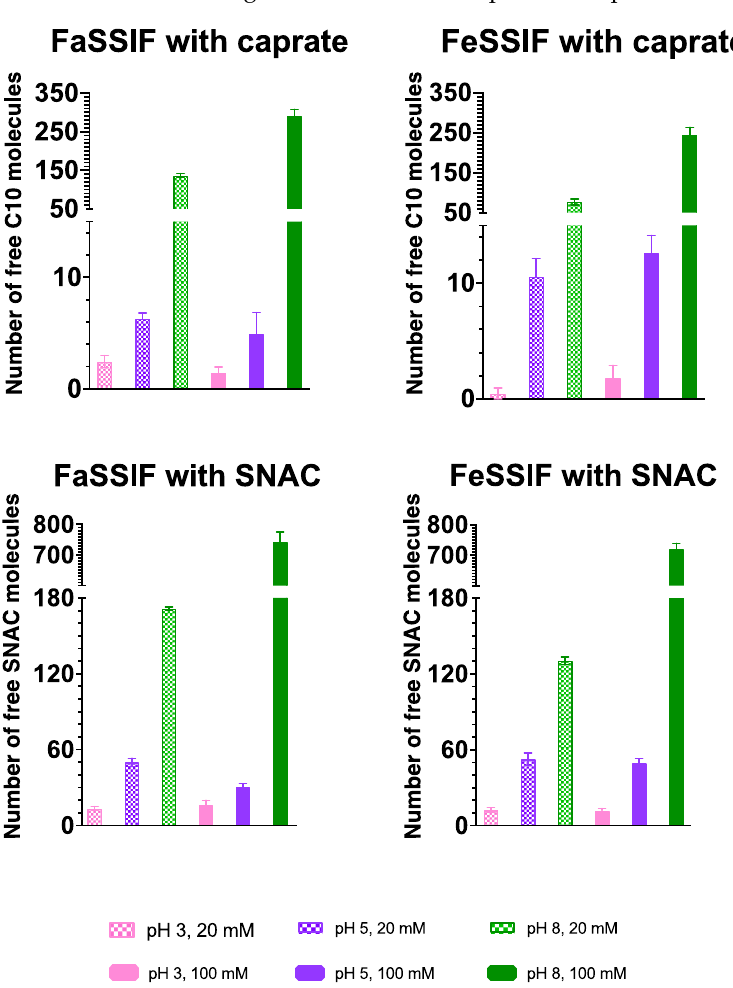
Figure 3. Number of free permeation enhancers, caprate (C10) and SNAC molecules, for all studied systems, presented as an average value and standard deviation calculated using the last 200 ns of the simulation trajectory.